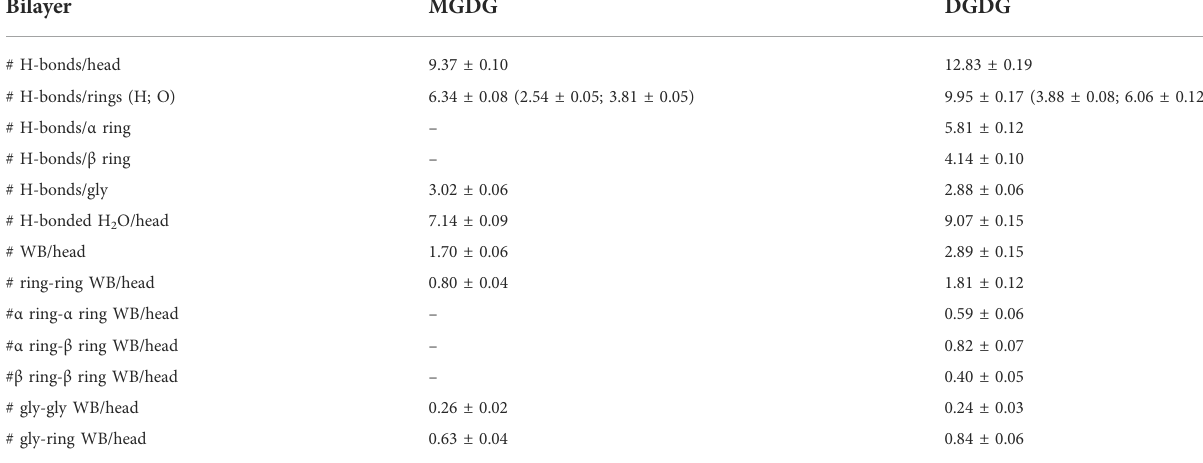
TABLE 2 Number of lipid-water interactions in the MGDG and DGDG lamellar bilayers.